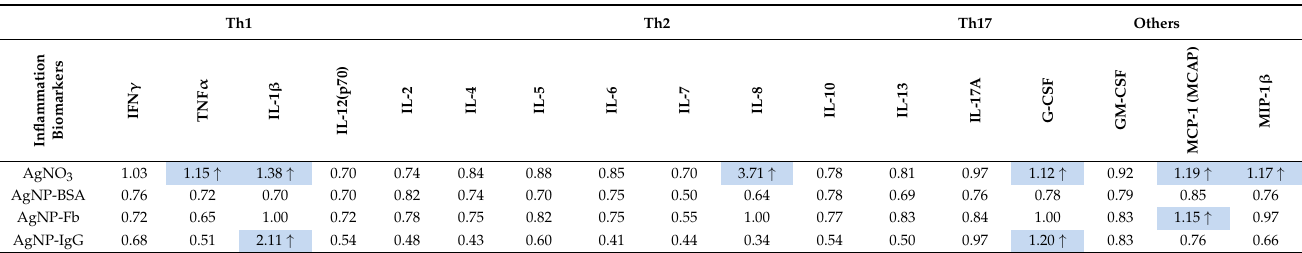
Table 1. Unknown (X) Multi Analyte Profiling (xMAP) results for 17 inflammation biomarkers in HEp-2 cells in 2 days post-treatment. Normalization was carried out as a ratio of mean fluorescence intensity (MFI) for wells after incubation with the nanosilver to MFI of control intact HEp-2